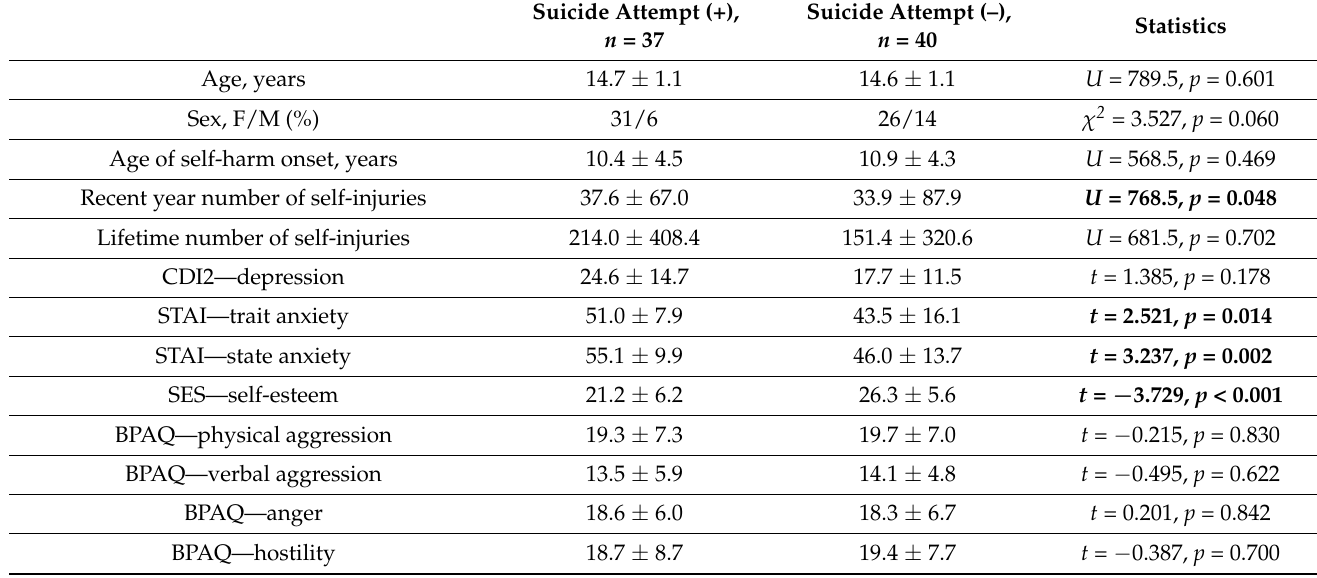
Table 1. General characteristics of the